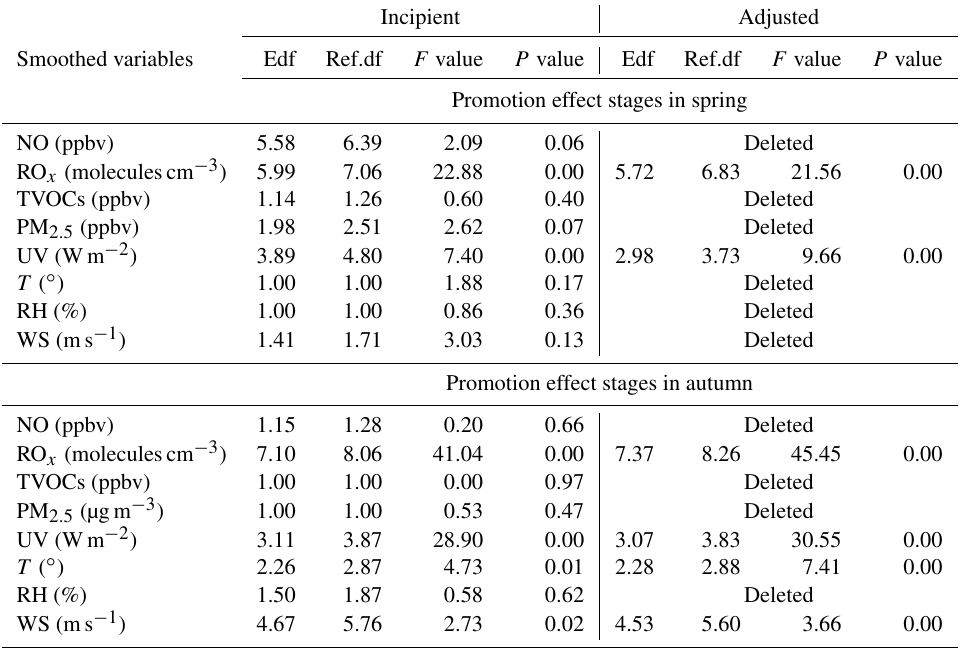
Table 2. Estimated degree (during promotion effect scenarios in spring and autumn) of freedom (Edf), degree of reference (Ref.df), P value, F value, deviance explained (%), adjusted R 2 , and deviance contribution (%) for the smoothed variables (including NO, RO x , TVOCs, PM 2 . 5 , UV, T , RH, and WS) in the multiple-factor GAM model. Incipient Adjusted Smoothed